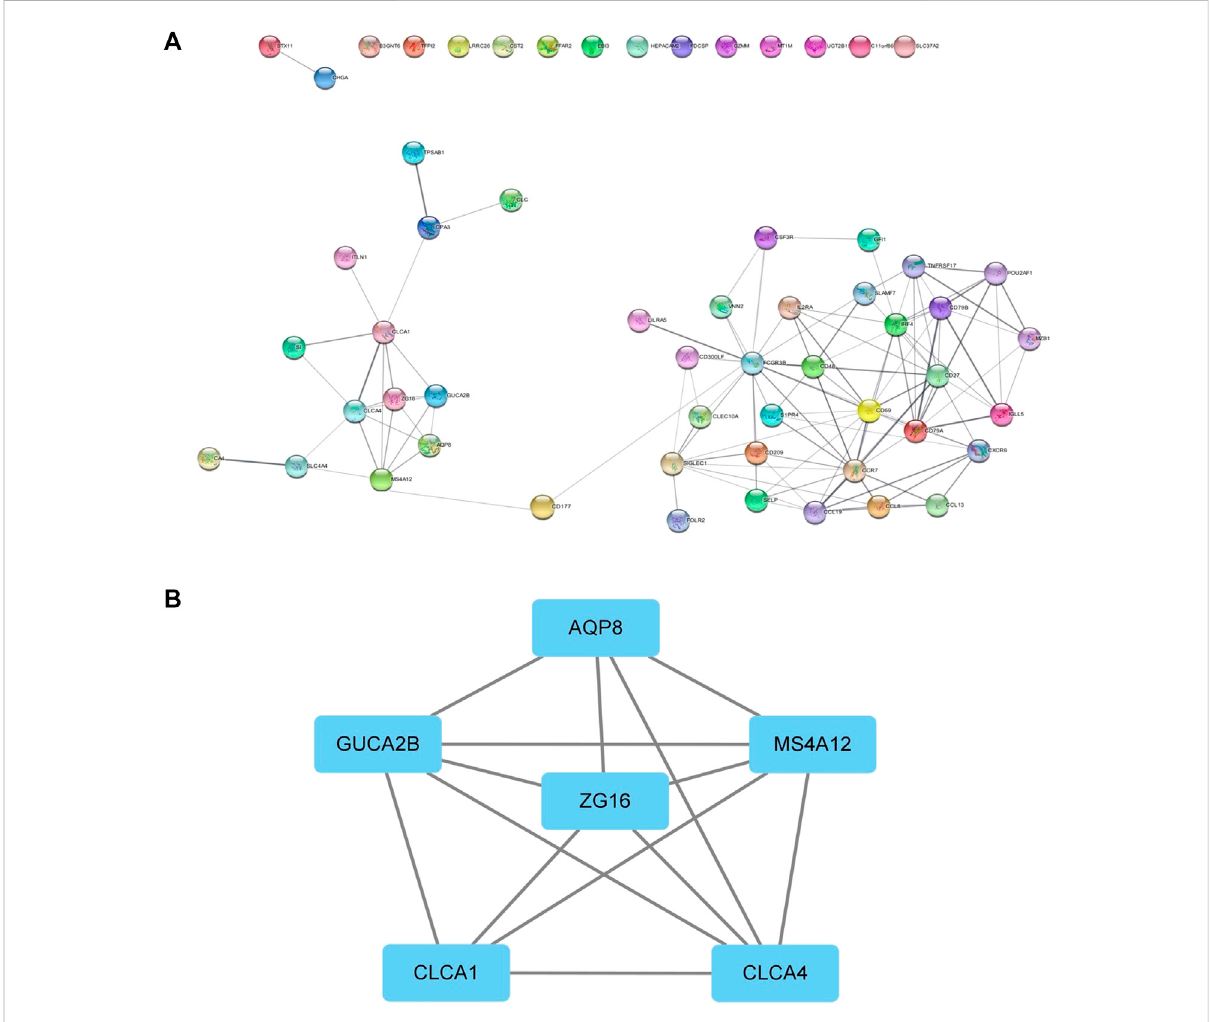
FIGURE 6 PPI network. (A) PPI of the STRING database. (B) Core regulatory networks selected by the MCODE plugin for Cytoscape.